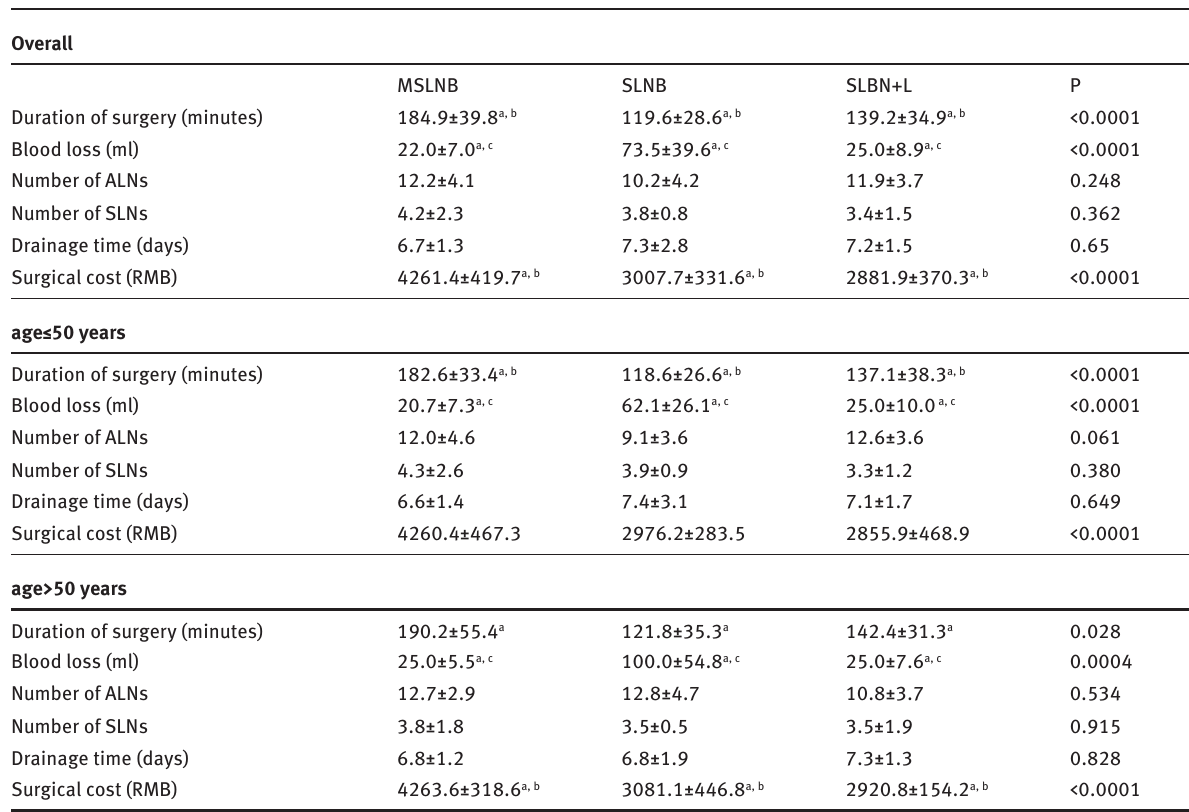
Table 2: Comparison of peri- and post-operative parameters among the three surgery groups.